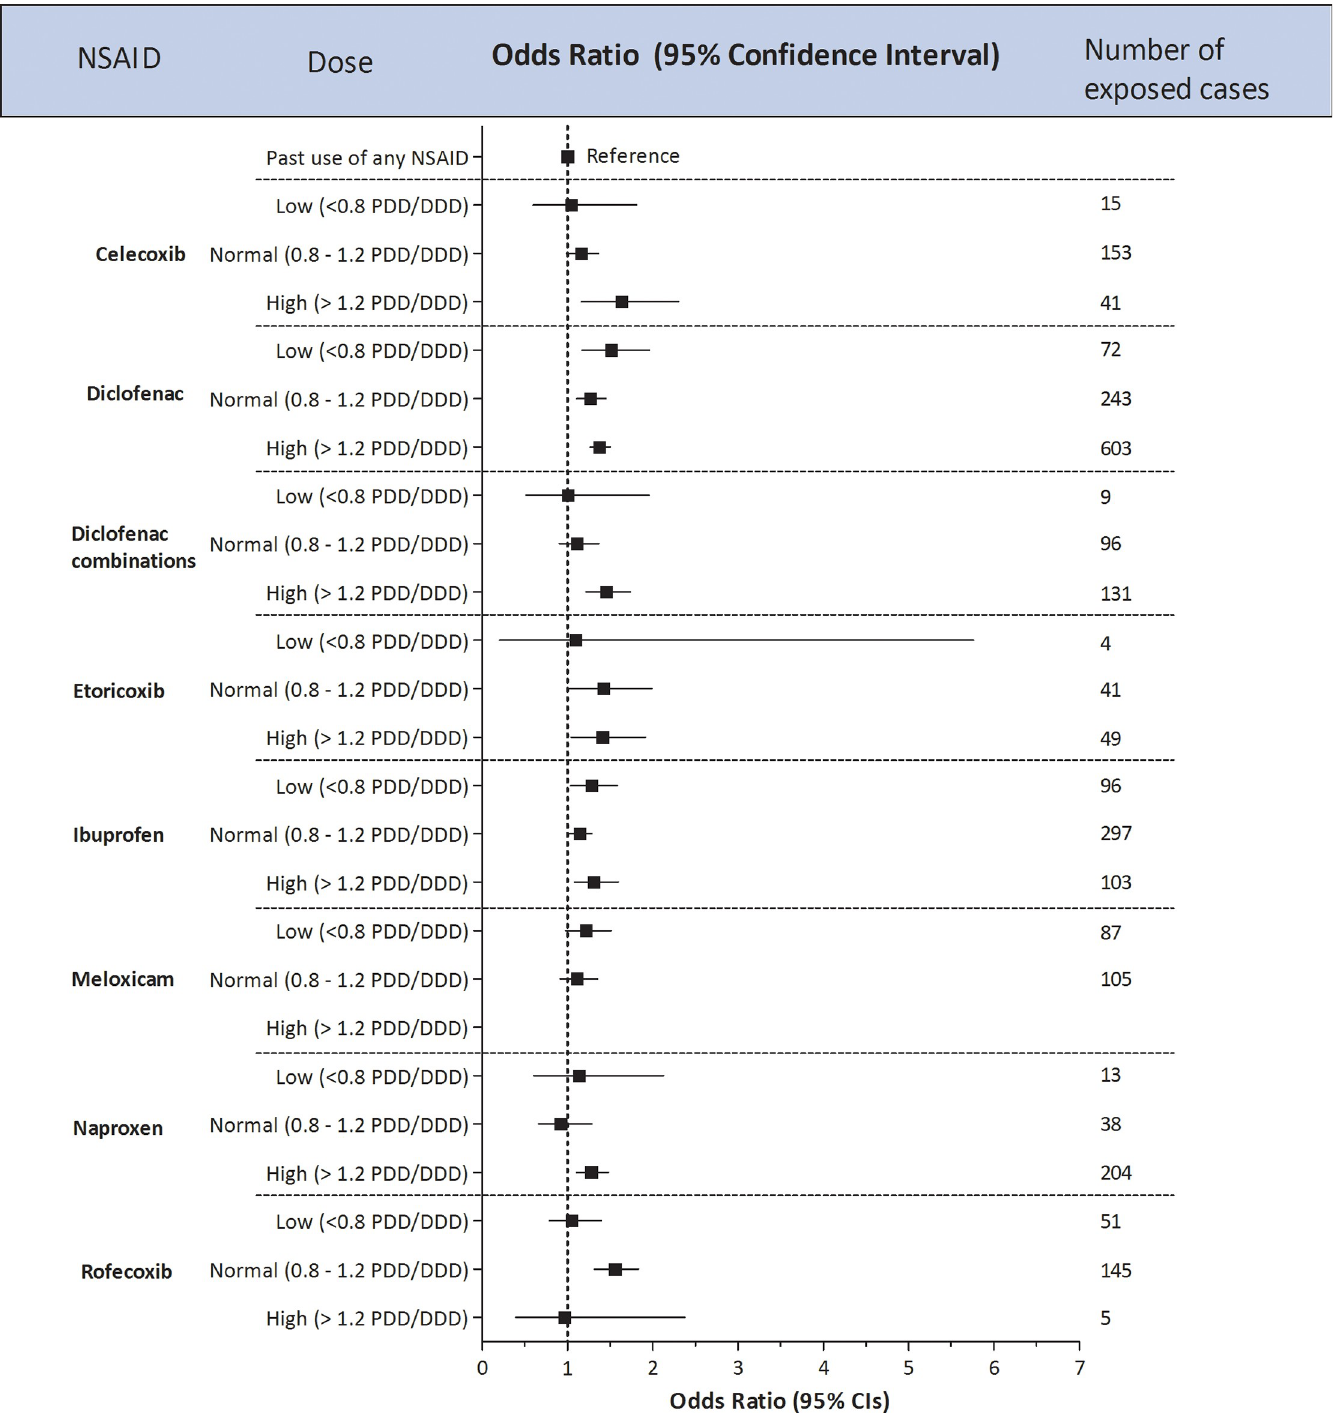
Fig 2. Adjusted risk estimates for AMI in current users for dose of use of individual NSAIDs in three databases pooled (THIN, IPCI, PHARMO), using past use of any NSAID as common reference group. PDD, prescribed daily dose; DDD, defined daily dose. Number of exposed cases do not add up to all current users of that particular NSAID in all three databases pooled as dose information could have been